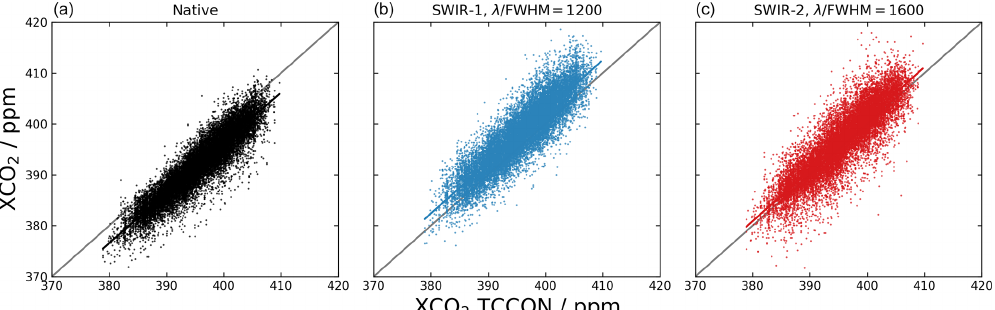
Figure 4. Correlation between XCO 2 retrieved from GOSAT with TCCON. (a) Native GOSAT retrieval; (b) SWIR-1 retrieval at 1200 resolving power; (c) SWIR-2 retrieval at 1600 resolving power. The grey line indicates a 1 : 1 correlation line; the colored lines show linear fits to the respective dataset. Standard deviations around TCCON amount to 2.43 (native, compare, for example, Guerlet et al., 2013b), 3.00 (SWIR-1) and 3.28ppm (SWIR-2).